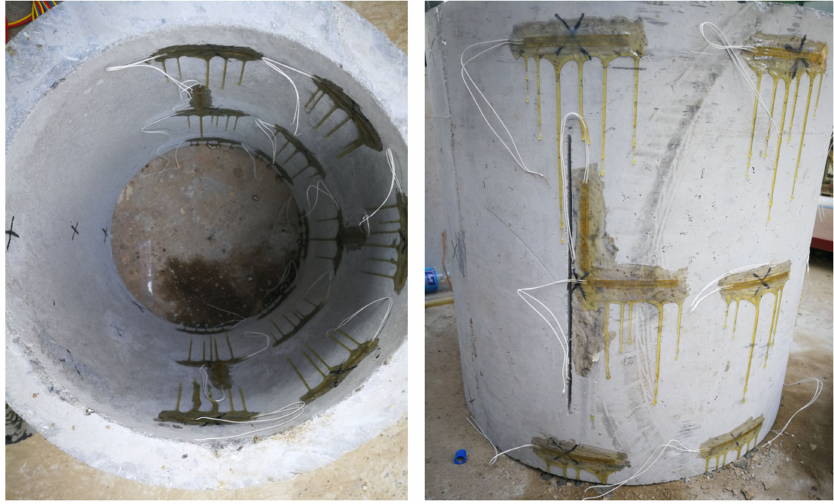
Figure 7. Gluing strain gages in position.